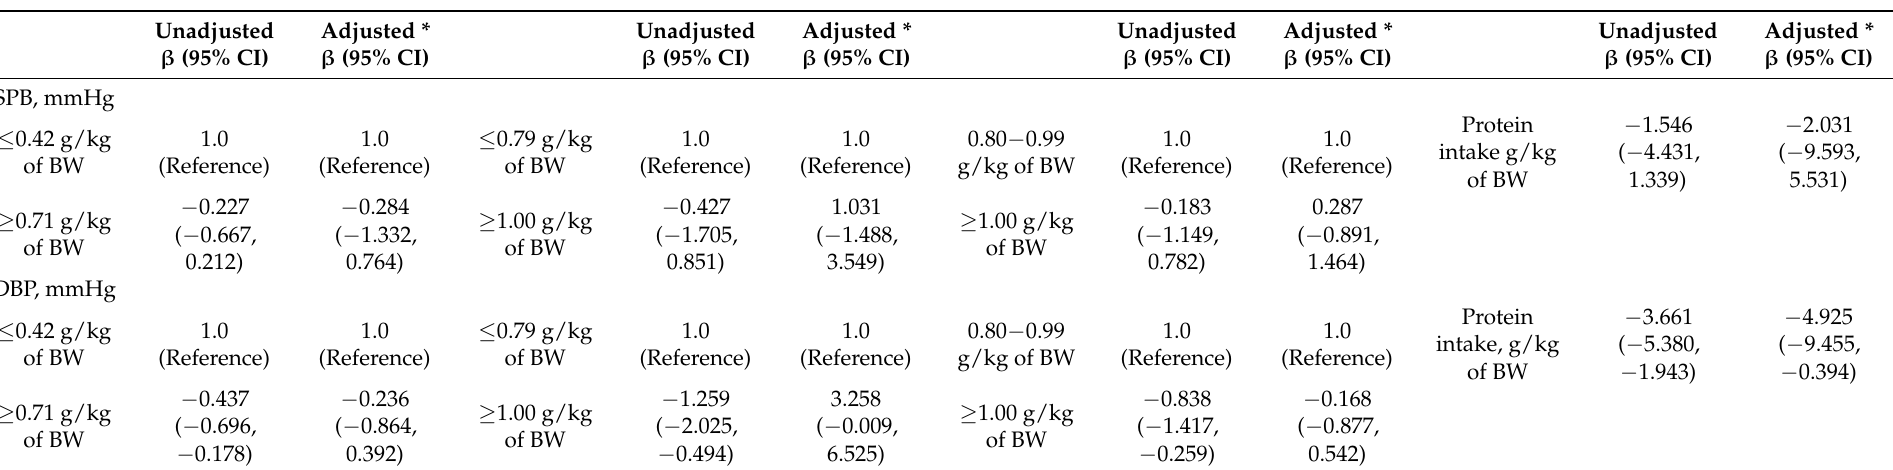
Table 3. Association between protein intake and blood pressure.